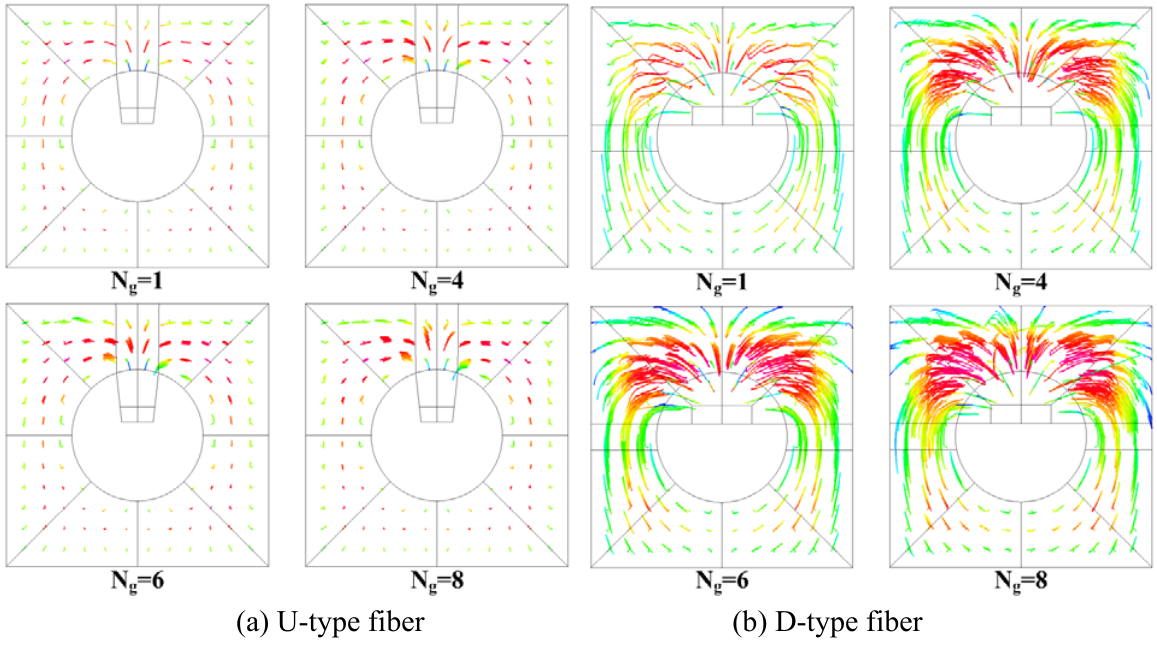
Figure 7. Mixing patterns in the FO-LPR microfluidic chip for (a) the U-type and (b) D- type fiber for numbers of